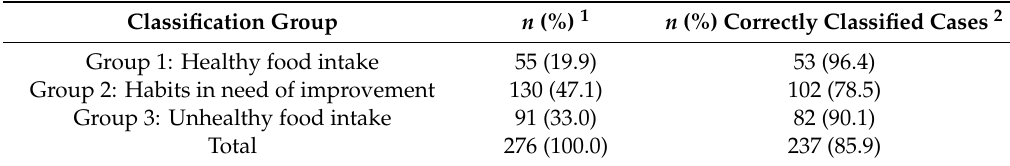
Table 5. Correct classification of cases according to the identified